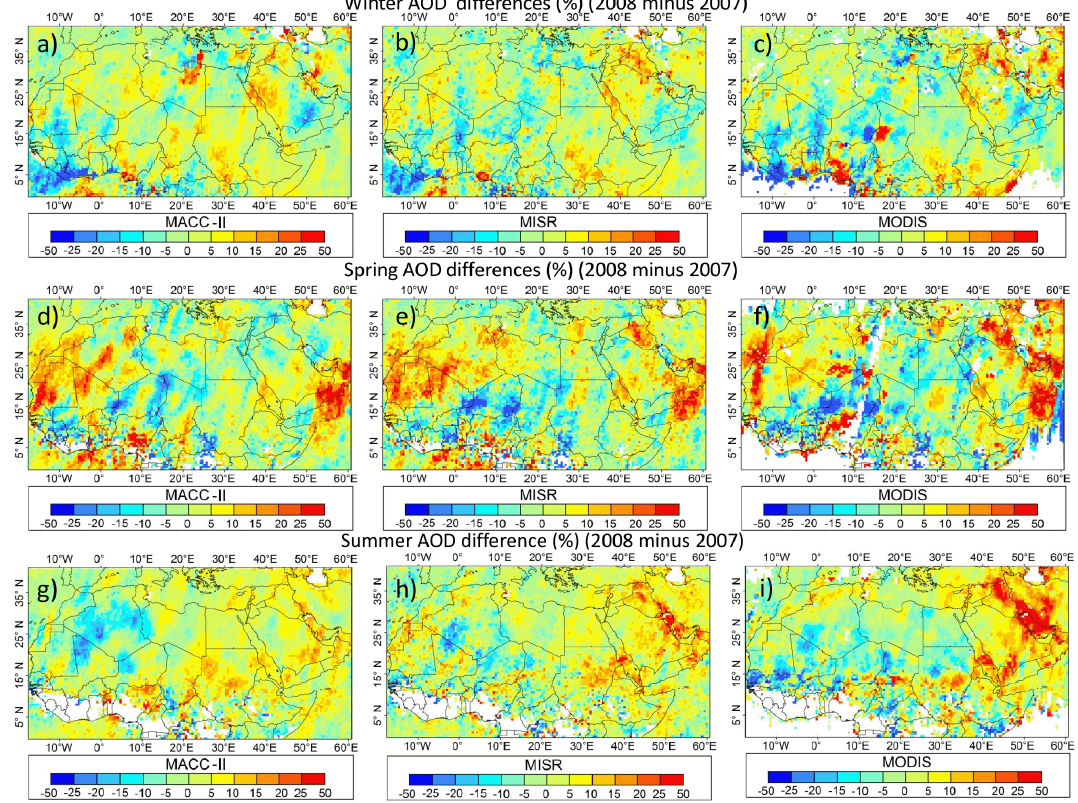
Figure 4. Interannual percentage variations of AOD (2008 minus 2007) from MACC-II, MODIS-Aqua and MISR for winter (JFM), spring (AMJ), summer